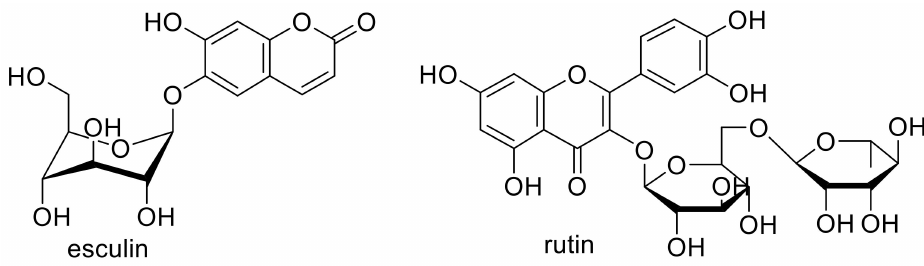
Figure 29. Structure of esculin and